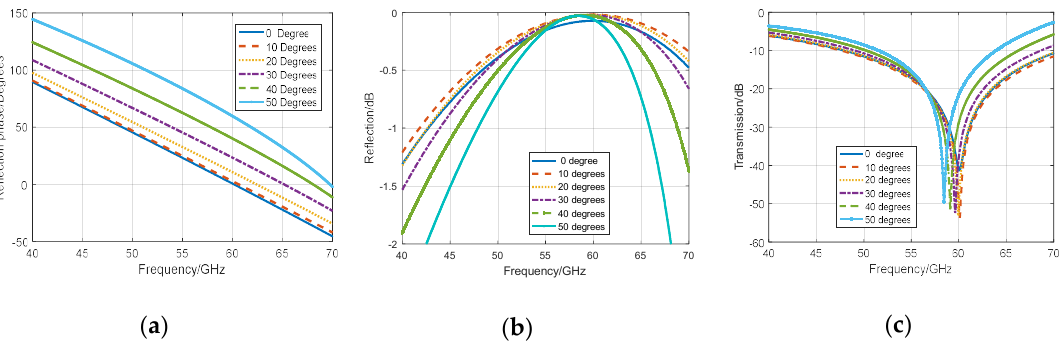
Figure 5. Reflection phase, reflection coefficient and transmission coefficient of the dual loop metasurface at a varied angle of incidence, θ: ( a ) Reflection phase, ( b ) reflection coefficient and ( c ) transmission coefficient.